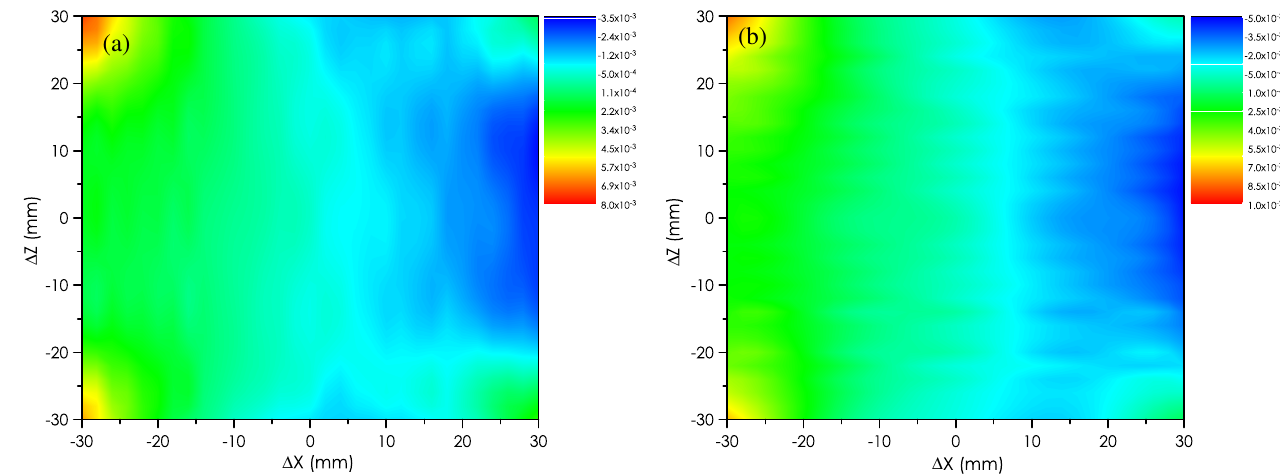
FIG. 10. Uniformity of the (a) horizontal GL, (cid:1) G x L=G x L , and (b) vertical GL, (cid:1) G z L=G z L , products along beam trajectory for the small-aperture magnet before corrections.